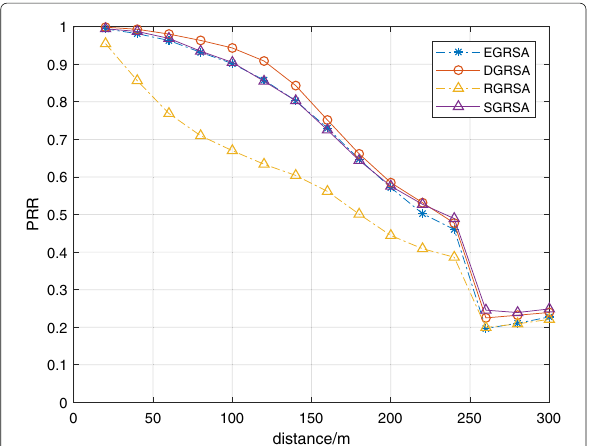
Fig. 20 The PRR of DGRSA when the number of VUEs is 600 in the jam scene. The packet reception ratio (PRR) curve changes with distance when jam areas are areas 1, 3, 6, 12, and 13 and the number of vehicle user equipments (VUEs) is 600. Four geo-based algorithms, namely random geo-based resource selection algorithm (RGRSA), sensing geo-based resource selection algorithm (SGRSA), the proposed enhanced geo-based resource selection algorithm (EGRSA), and the proposed dynamic geo-based resource selection algorithm (DGRSA), are compared in this figure. The line with red circles represents the proposed DGRSA. The line with blue stars represents the proposed EGRSA. The line with purple triangles represents the SGRSA. The line with yellow triangles represents